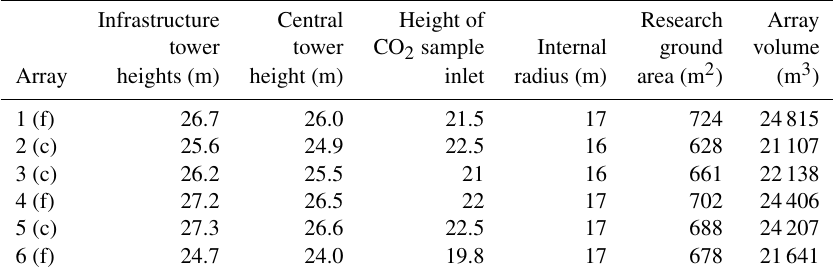
Table 1. Geometries of the BIFoR FACE control (c) and fumigation (f) arrays. The internal radius is defined as the mean distance between the central tower and the inside edge of the towers supporting the perforated vent pipes. Infrastructure Central Height